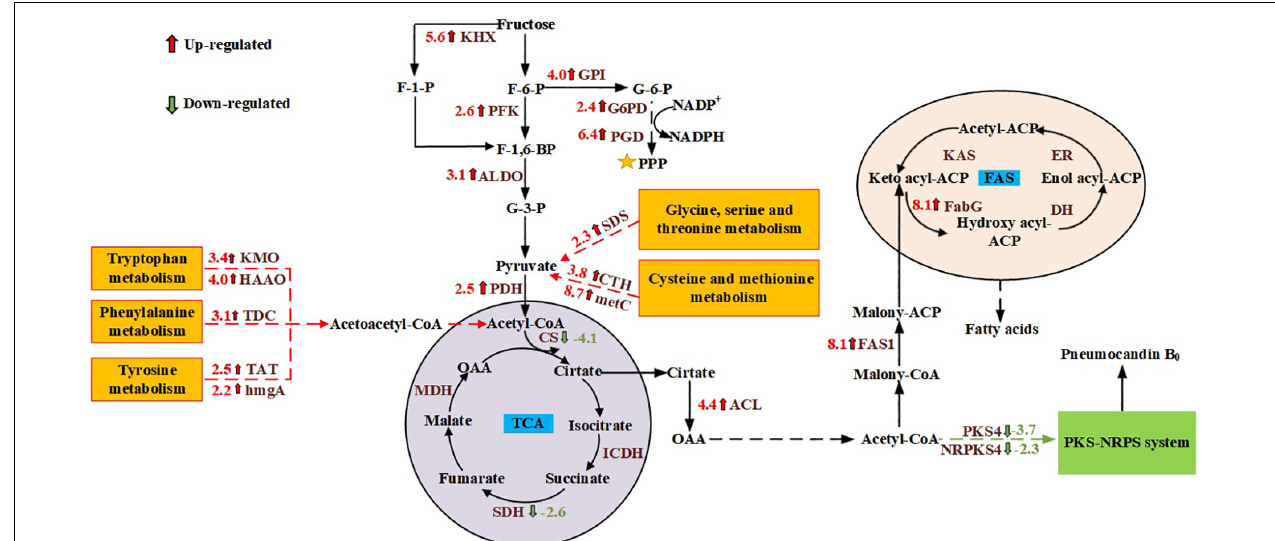
FIGURE 5 | Changes in the transcript abundance of genes involved in central metabolic pathways, fatty acid biosynthesis, and the PKS-NRPS pathway. Key enzymes with logFC values are included in the map with their names written out. Red represents up- and blue represents downregulation. KHX,